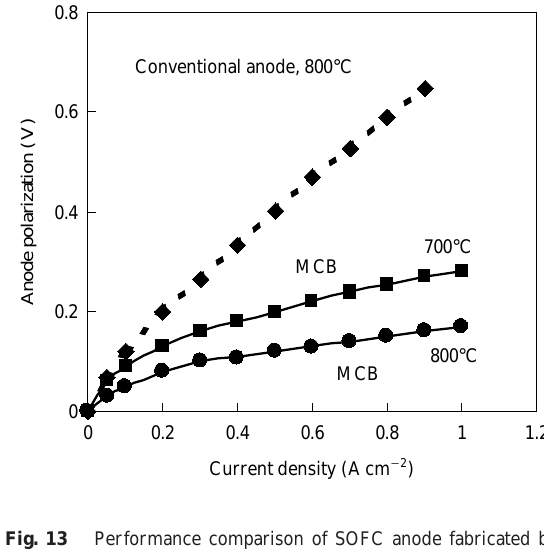
Ni-YSZ cermet anode fabricated from NiO-YSZ compos- ite particles